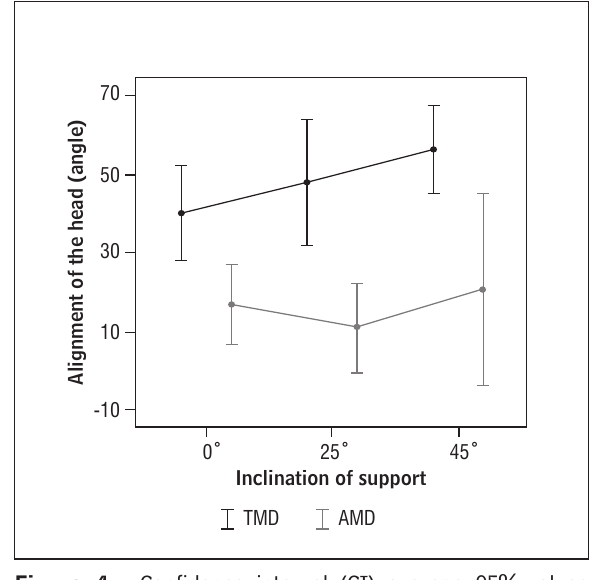
Figure 4 - Confidence interval (CI) average 95 % values of the alignment of the head during the second maximum straightening of the head in the prone position with inclinations of 0°, 25° and 45° in the groups with typical motor develop- ment (TMD, n = 18) and atypical motor devel- opment (AMD, n = 11)